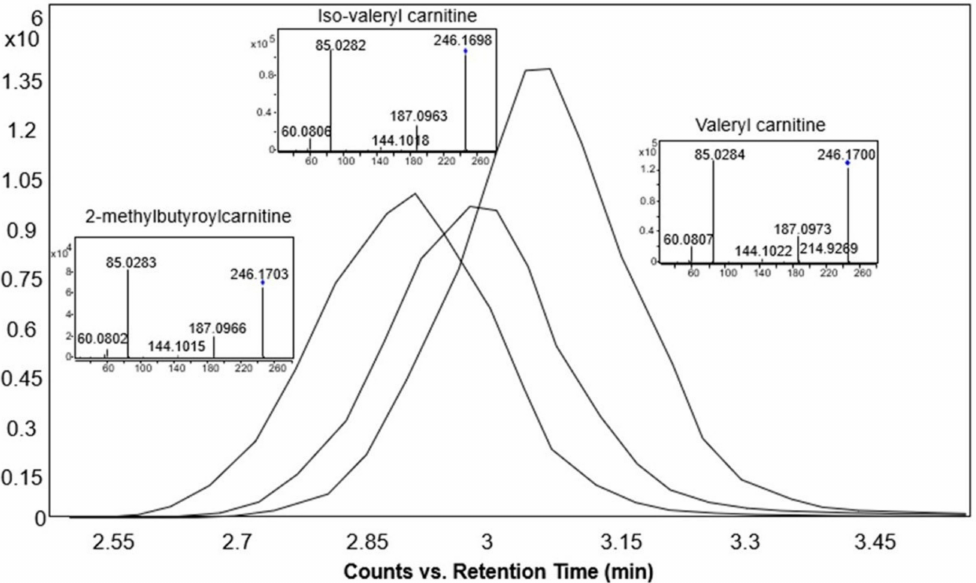
Figure 7. Extracted ion chromatograms and MS/MS spectra of the base peak spectra of 2-methylbutyroylcarnitine, iso-valeryl carnitine, and valeryl carnitine standards at 10 eV collision energy in the positive ionization mode.